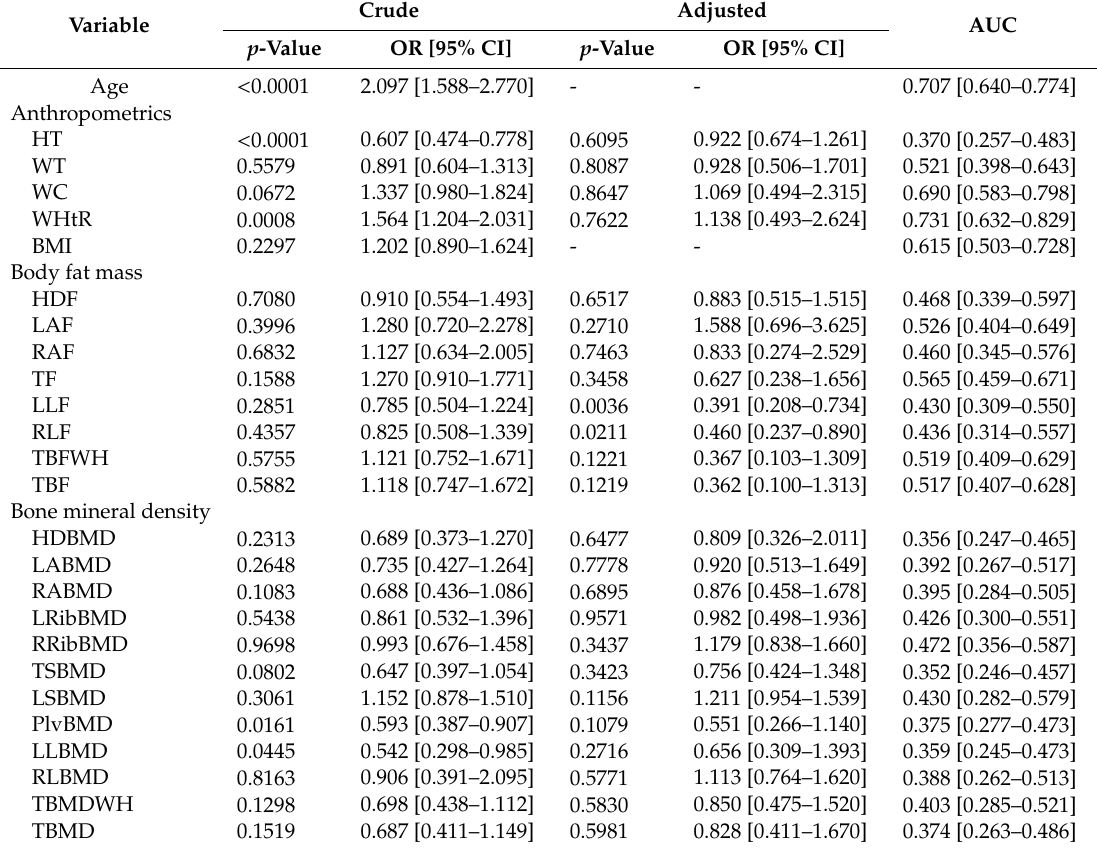
Table6. Comparisonofanthropometricandbodycompositionindicesinwomenwithbothhypertension and